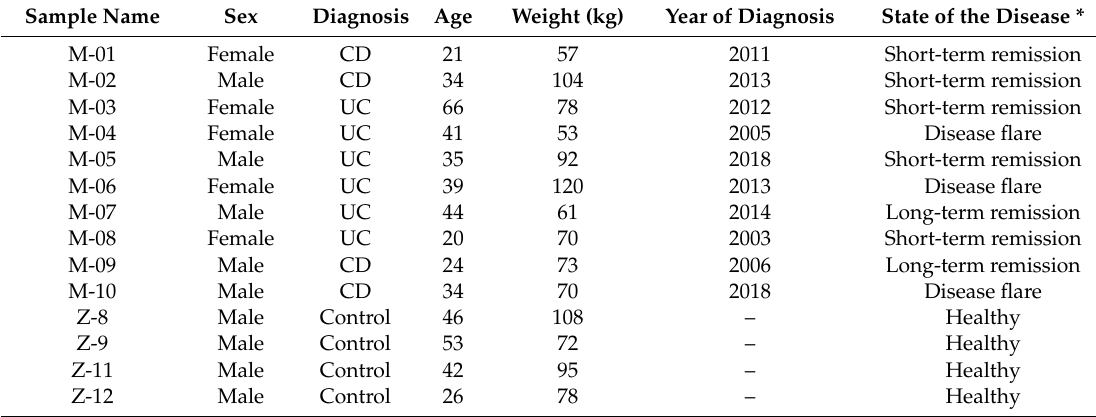
Table 1. Patients and control subject’s characteristics.